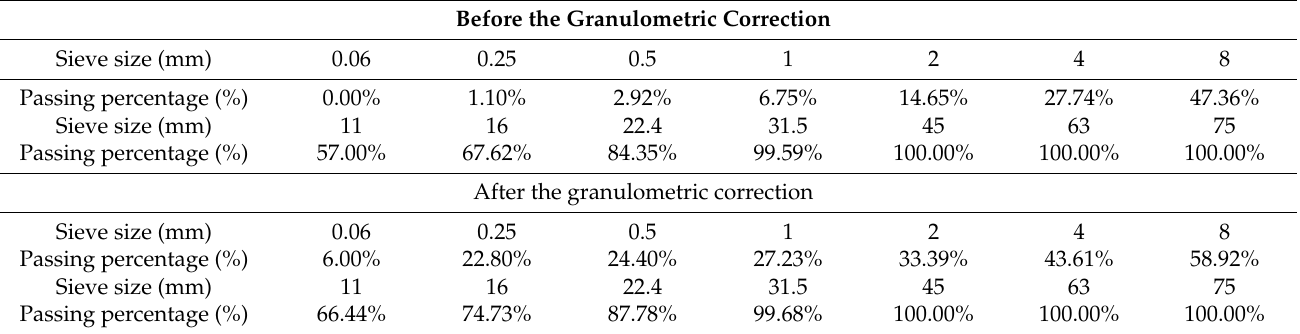
Table 3. Granulometric composition of recycled